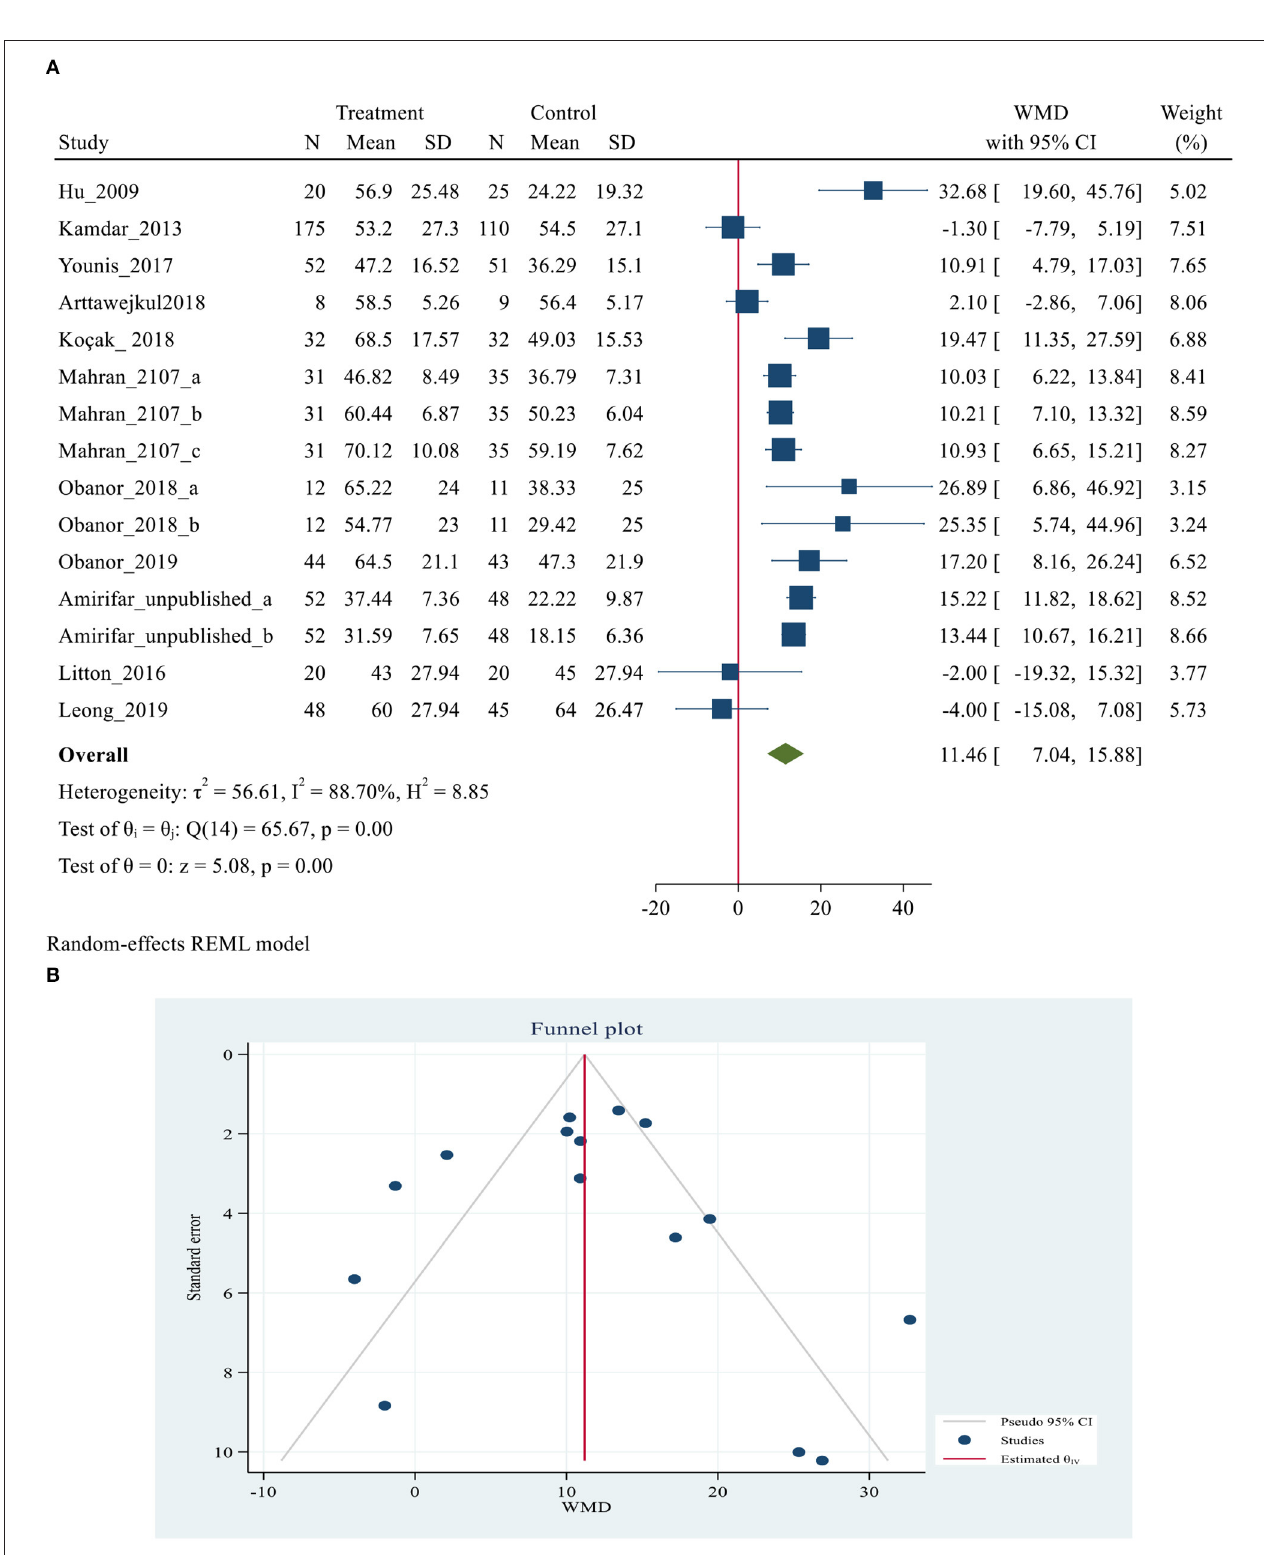
FIGURE 3 | (A) Forest plot of mean difference (MD) for sleep quality based on RCSQ between intervention and control groups. (B) Funnel plot showing publication bias on RCSQ -based sleep quality.